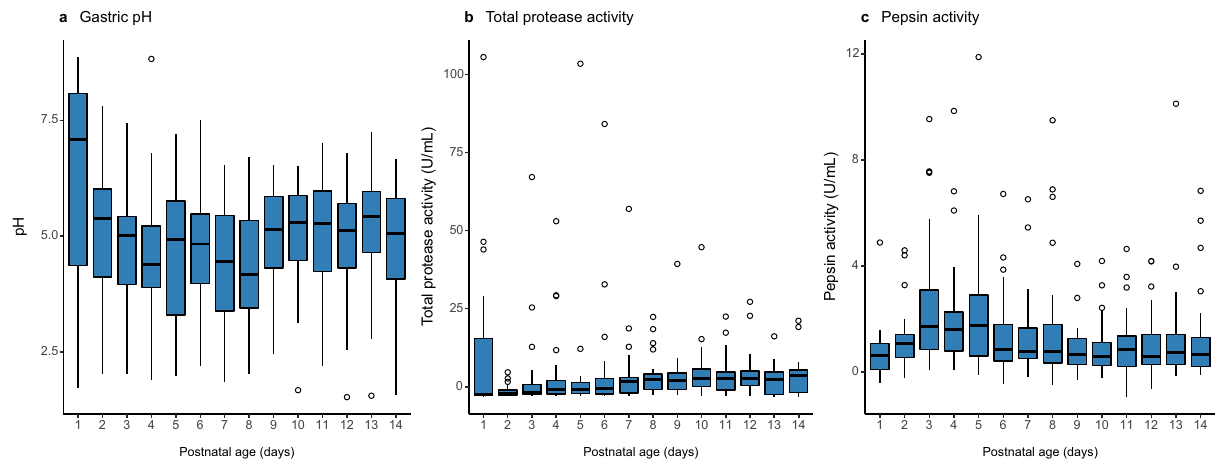
Figure 2. Gastric pH and enzyme activity during the first two postnatal weeks of preterm infants. Dynamics of ( a ) gastric pH, ( b ) total protease activity and ( c ) pepsin activity. Boxplots show the median, 25th and 75th percentiles, and minimal and maximal values with the exception of outliers (circles, lower or higher than 1.5 * inter-quartile